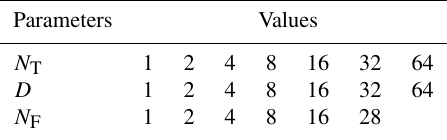
Figure 5. Hyperparameter optimization using grid search results (cross). Dashed lines represent the best-fit Richards curve. (a) The optimal values are extracted from the locations where the score increments per unit of each hyperparameter become lower than a threshold (e.g. 0.001). (b) If the curve does not fit the grid search results well, (c) the difference between training and test scores is used to find the locations where it does not exceed a threshold (e.g. 0.03) in order to avoid